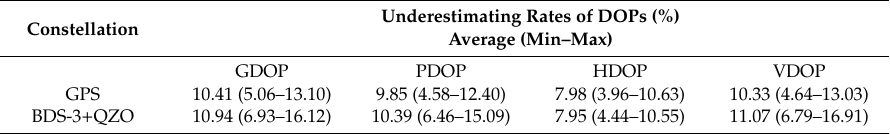
Figure 3. Estimation and reference value of the number of visible satellites for 32 Global Positioning System (GPS) satellites and the BDS-3+QZO constellation at all latitudes ( − 90° S–90° N) for the cutoff elevation angle (CEA) of 5°. ( a ) Estimation and reference value of the number of visible satellites for 32 GPS satellites; ( b ) Estimation and reference value of the numbers of visible satellites for BDS-3+QZO. Table 2. Average, minimal, and maximal underestimating rates of the estimated GPS and BDS-3 + QZO DOPs ((GDOP (geometric DOP), HDOP (horizontal DOP), PDOP (position DOP), TDOP (time DOP), and VDOP (vertical DOP) )) relative to the reference values ((reference-estimation) / reference × 100%) over